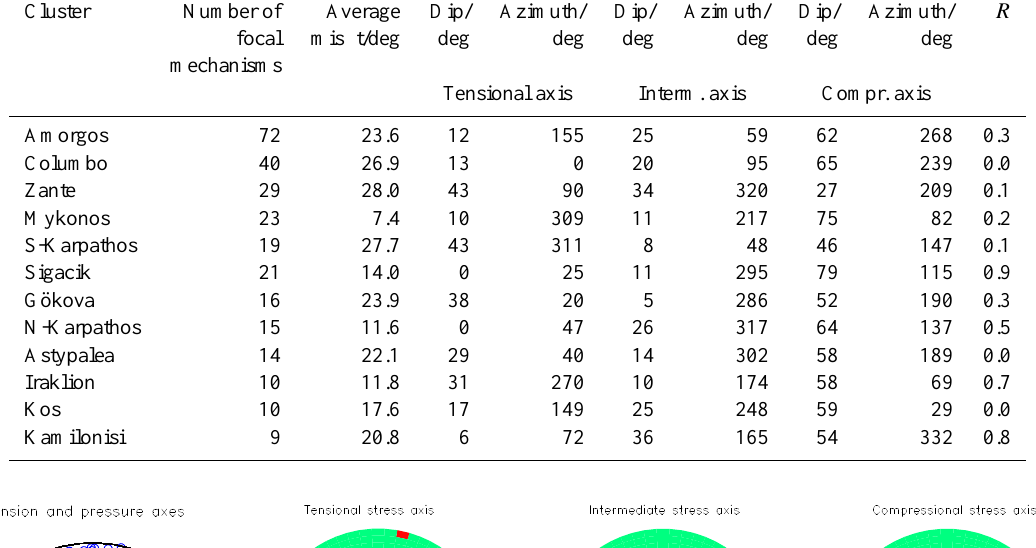
Table 1. Summary of stress inversion results for shallow earthquake clusters. Clusters are ordered according to the number of available focal mechanisms. Azimuth is measured in degrees from north over east.